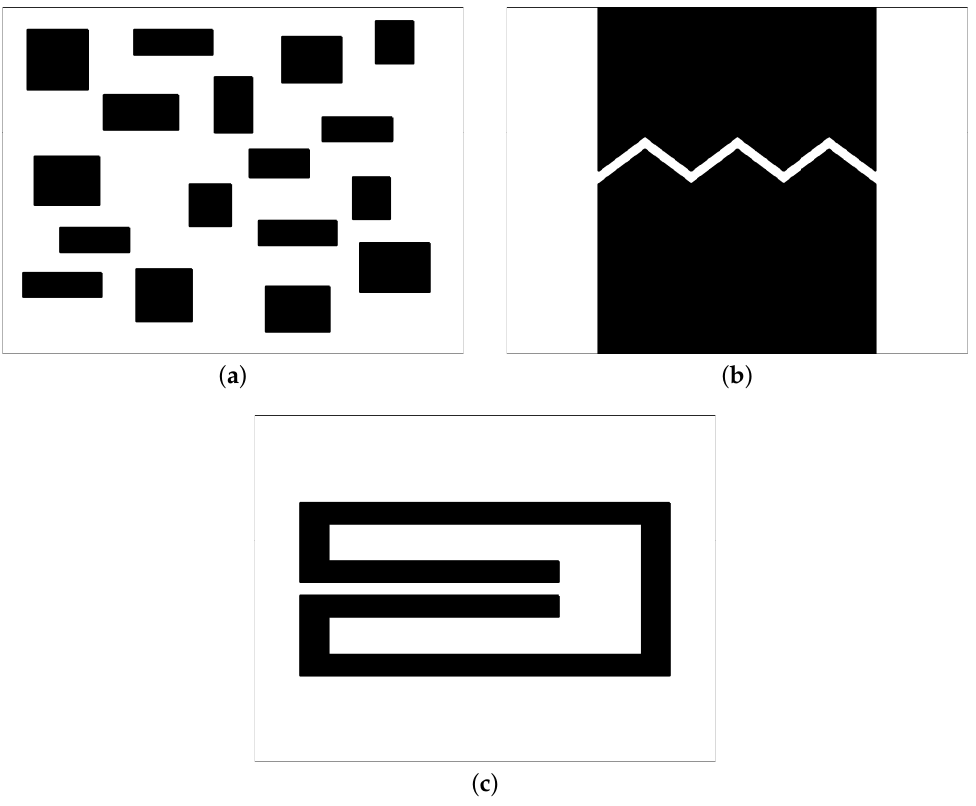
Figure 7. Three different maps in the experiment. ( a ) Complex; ( b ) Narrow passage; ( c ) Bug